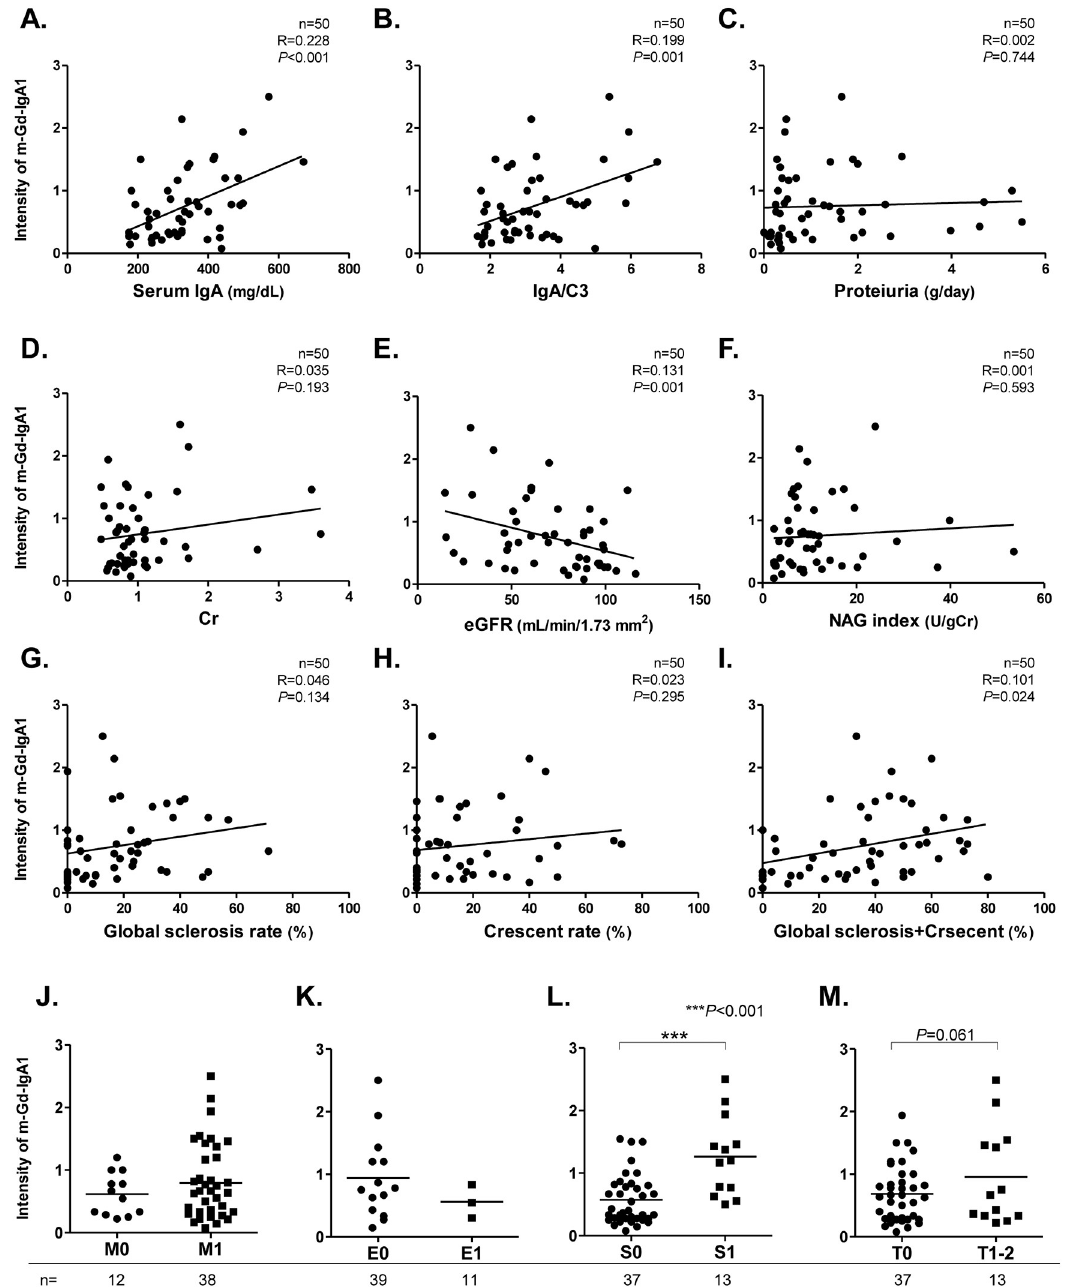
Fig 4. Correlations between m-Gd-IgA1 deposition and laboratory parameters or pathological findings in patients with IgAN. Scatter plots of m-Gd-IgA1 intensity vs. serum IgA ( A ), serum IgA/C3 ratio ( B ), proteinuria ( C ), sCr ( D ), eGFR ( E ), urinary NAG index ( F ), global sclerosis ( G ), crescents ( H ), and global sclerosis and crescents ( I ). Rates of global sclerosis, crescents, and both glomerular lesions (%) were calculated by dividing total numbers of each lesion by otal number of glomeruli. Crescents comprised cellular, fibrocellular, and fibrous types. Mesangial-Gd-IgA1 intensity was compared based on Oxford classification ( J-M ). Patients with IgAN were assigned to groups according to mesangial hypercellularity ( J ), endocapillary hypercellularity ( K ), segmental glomerulosclerosis ( L ), and tubular atrophy/interstitial fibrosis ( M ). Horizontal solid lines represent means. Data were statistically analyzed using Mann-Whitney U tests and Spearman correlation tests.